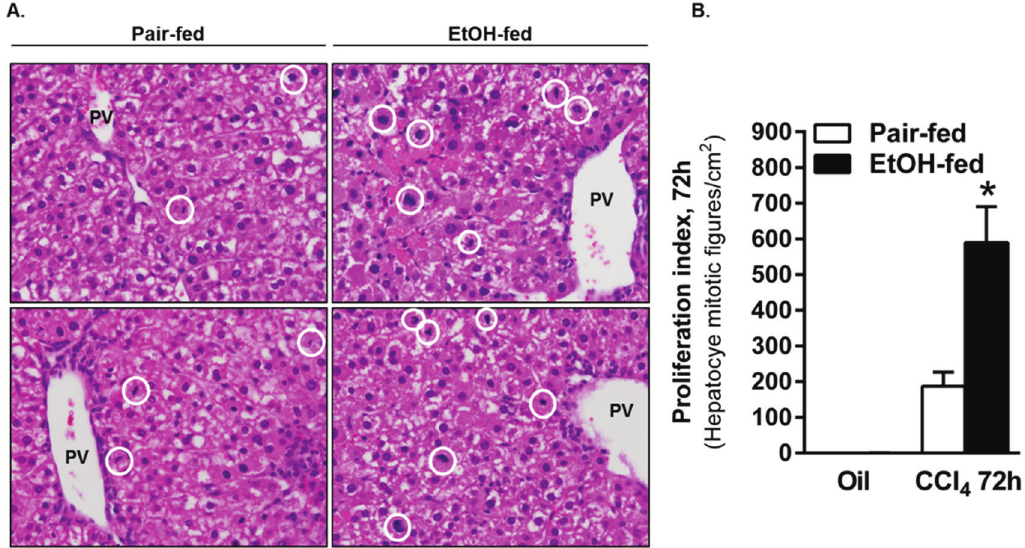
Figure 9. The number of mitotic figures was greater in livers from ethanol-fed mice 72 h after CCl 4 exposure. ( A ) Representative images from H&E stained liver sections taken from mice 72 h after CCl 4 exposure. Mitotic figures were found predominantly in Zones 1 and 2, so the images were captured using the portal vein as a landmark. The white circles in each image outline mitotic cells. ( B ) Graphical representation of the number of mitotic cells in livers from pair and ethanol-fed mice 72 h after CCl 4 exposure. Mitotic figures were rare or not present at other time points evaluated. N = 4–8 mice per group. * p < 0.05.